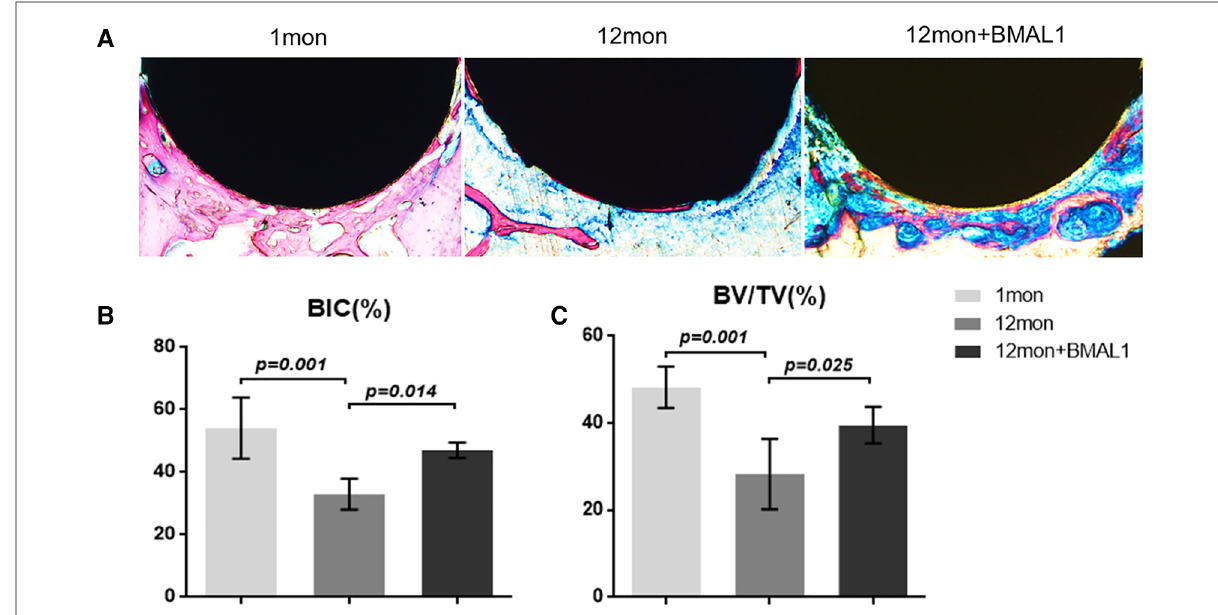
FIGURE 5 Histologic analyses of femurs with implants. ( A ) Representative image of histological sections after 2 weeks healing. ( B , C ) Quantitative analyses of BIC (%) and BV/TC (%), respectively, through histological images. ( n =4). BIC, bone-to-implant contact; BV/TV, bone volume